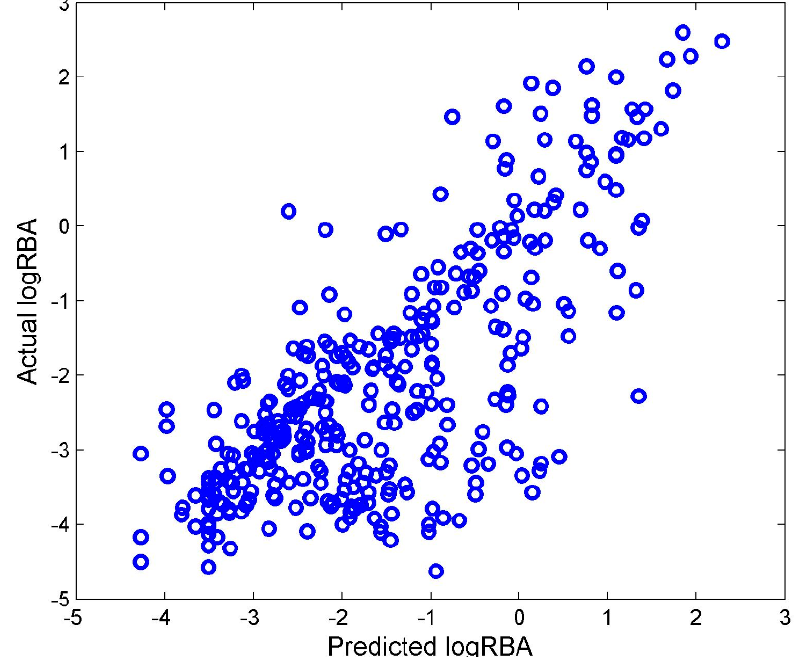
Figure 6. External validation results. The x-axis indicates actual logRBA values and the y-axis gives the estimated logRBA values from model M-3 that was developed using TS-3.